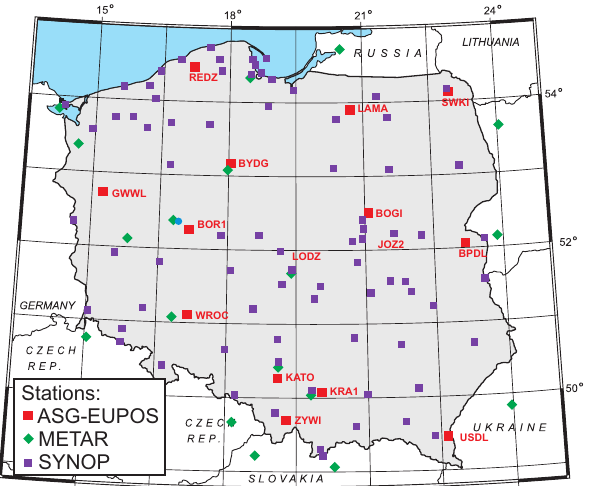
Fig. 2. Ground stations of meteorological networks (ASG-EUPOS: 15, METAR: 22, SYNOP: 84) in the area of Poland (7 Novem- ber 2011).